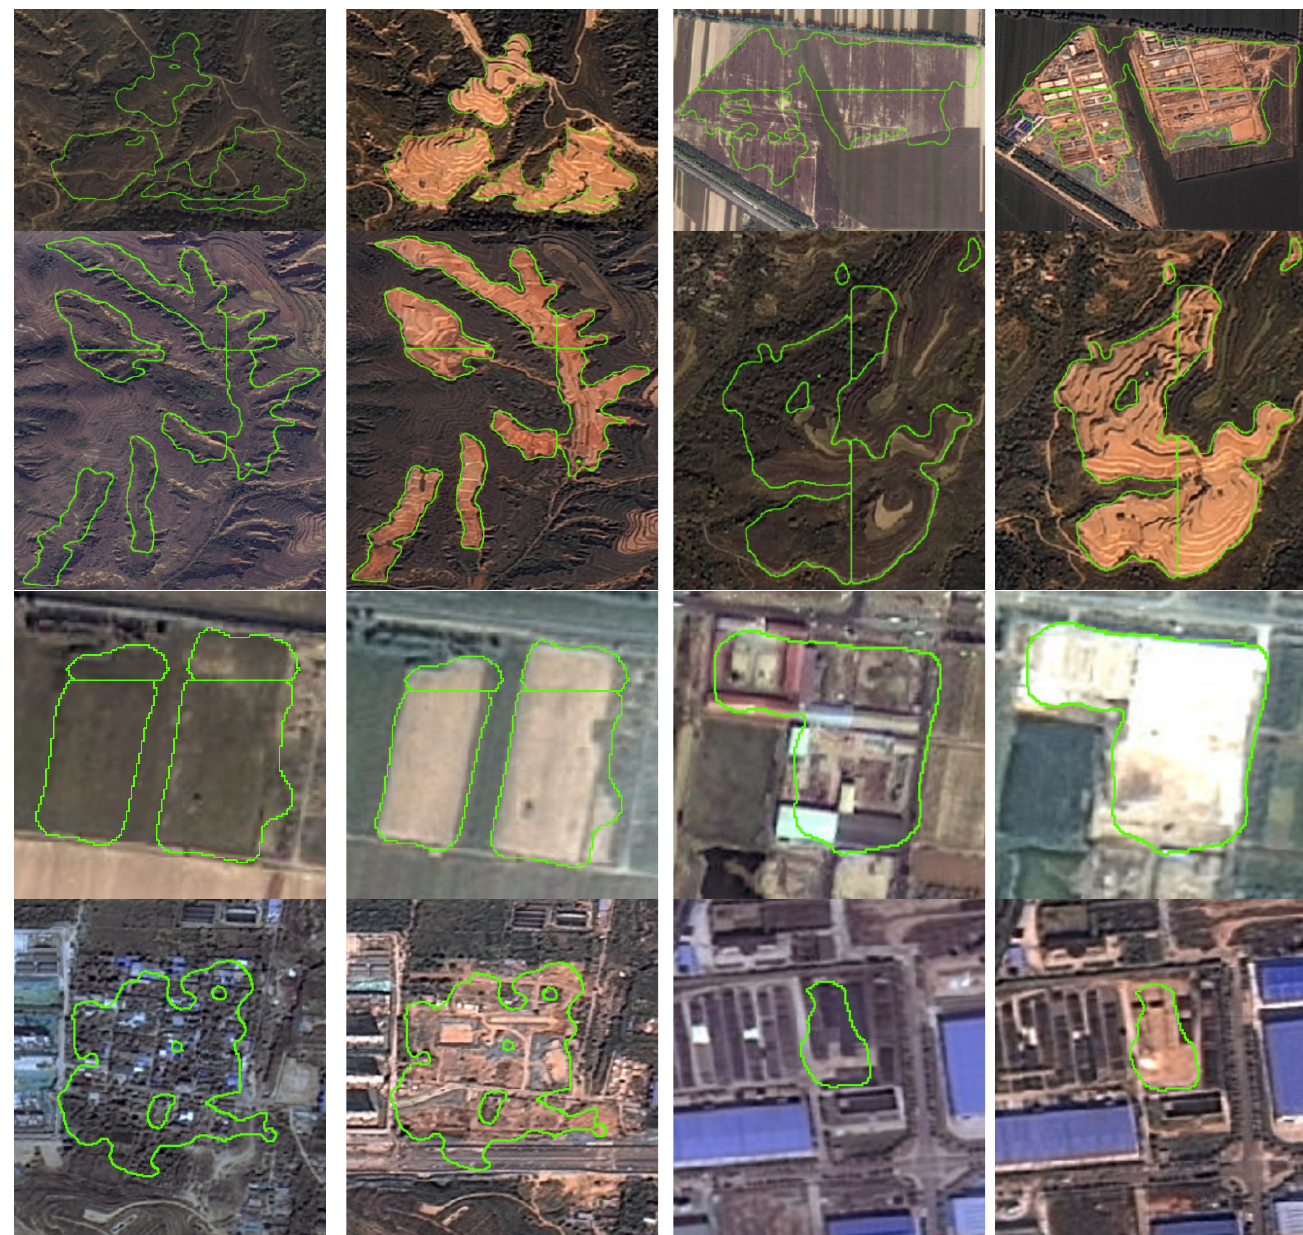
Figure 10. Example of automatic extracted new bare land parcels Table 1. Automatic feature extraction accuracy.